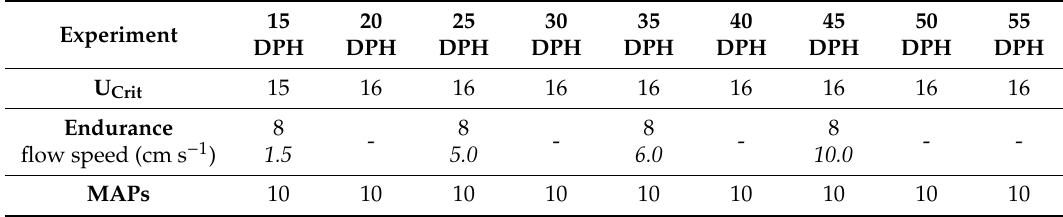
Table 1. Number of white seabream Diplodus sargus (Linnaeus, 1758) larvae used in the critical swimming speed (U Crit ), endurance (water flow speed is in italics), and Modal Action Patterns (MAPs) experiments at nine occasions along ontogeny—15, 20, 25, 30, 35, 40, 45, 50, and 55 days post-hatching